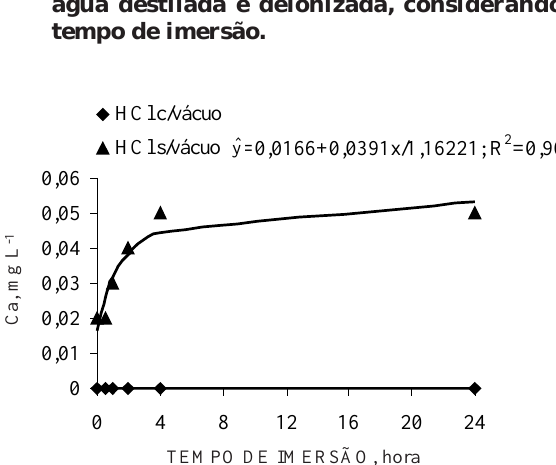
Figura 5. Cálcio na água de imersão das cápsulas tratadas com HCl 0,1 mol L -1 mais 45 min em água destilada e deionizada, considerando o tempo de imersão.